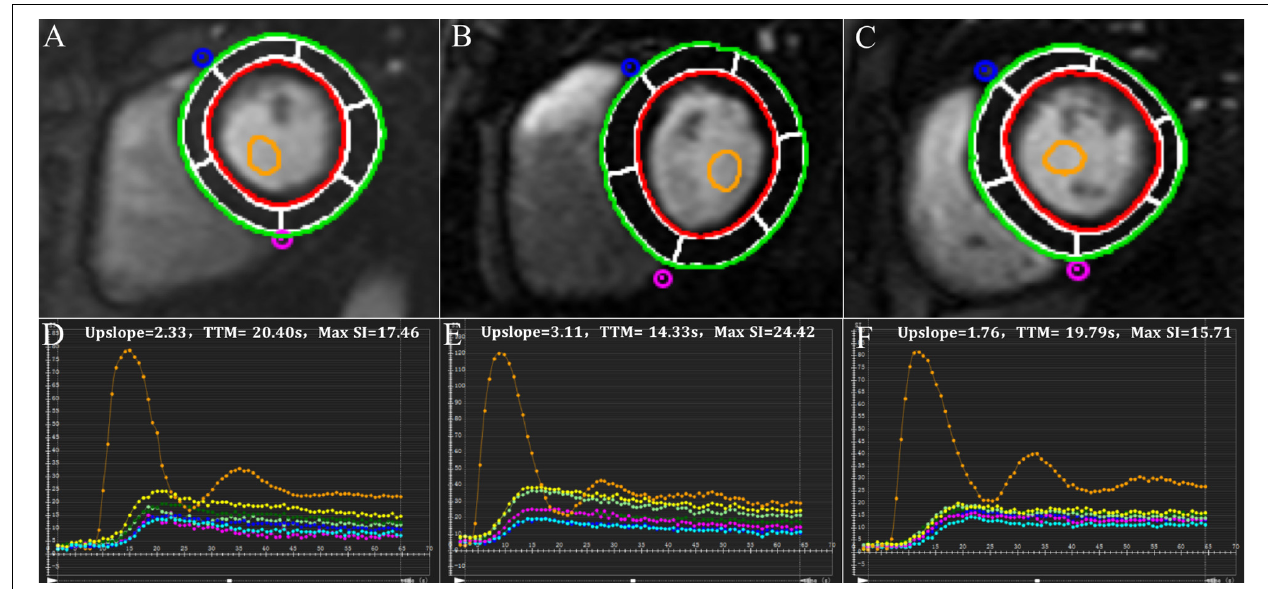
FIGURE 1 | Representative first-pass myocardial perfusion MR images and signal intensity-time curves of a control subject (A,D) , a hypertensive patient without obesity (B,E) and a hypertensive patient with obesity (C,F) .